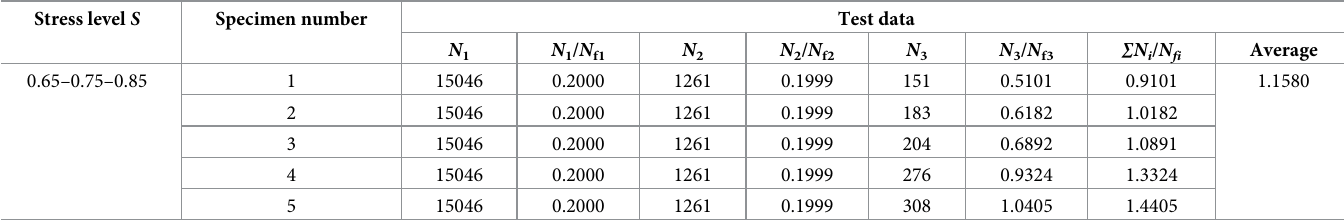
Table 16. Test results of flexural fatigue damage of concrete under three-stage loading (low-high order). Stress level